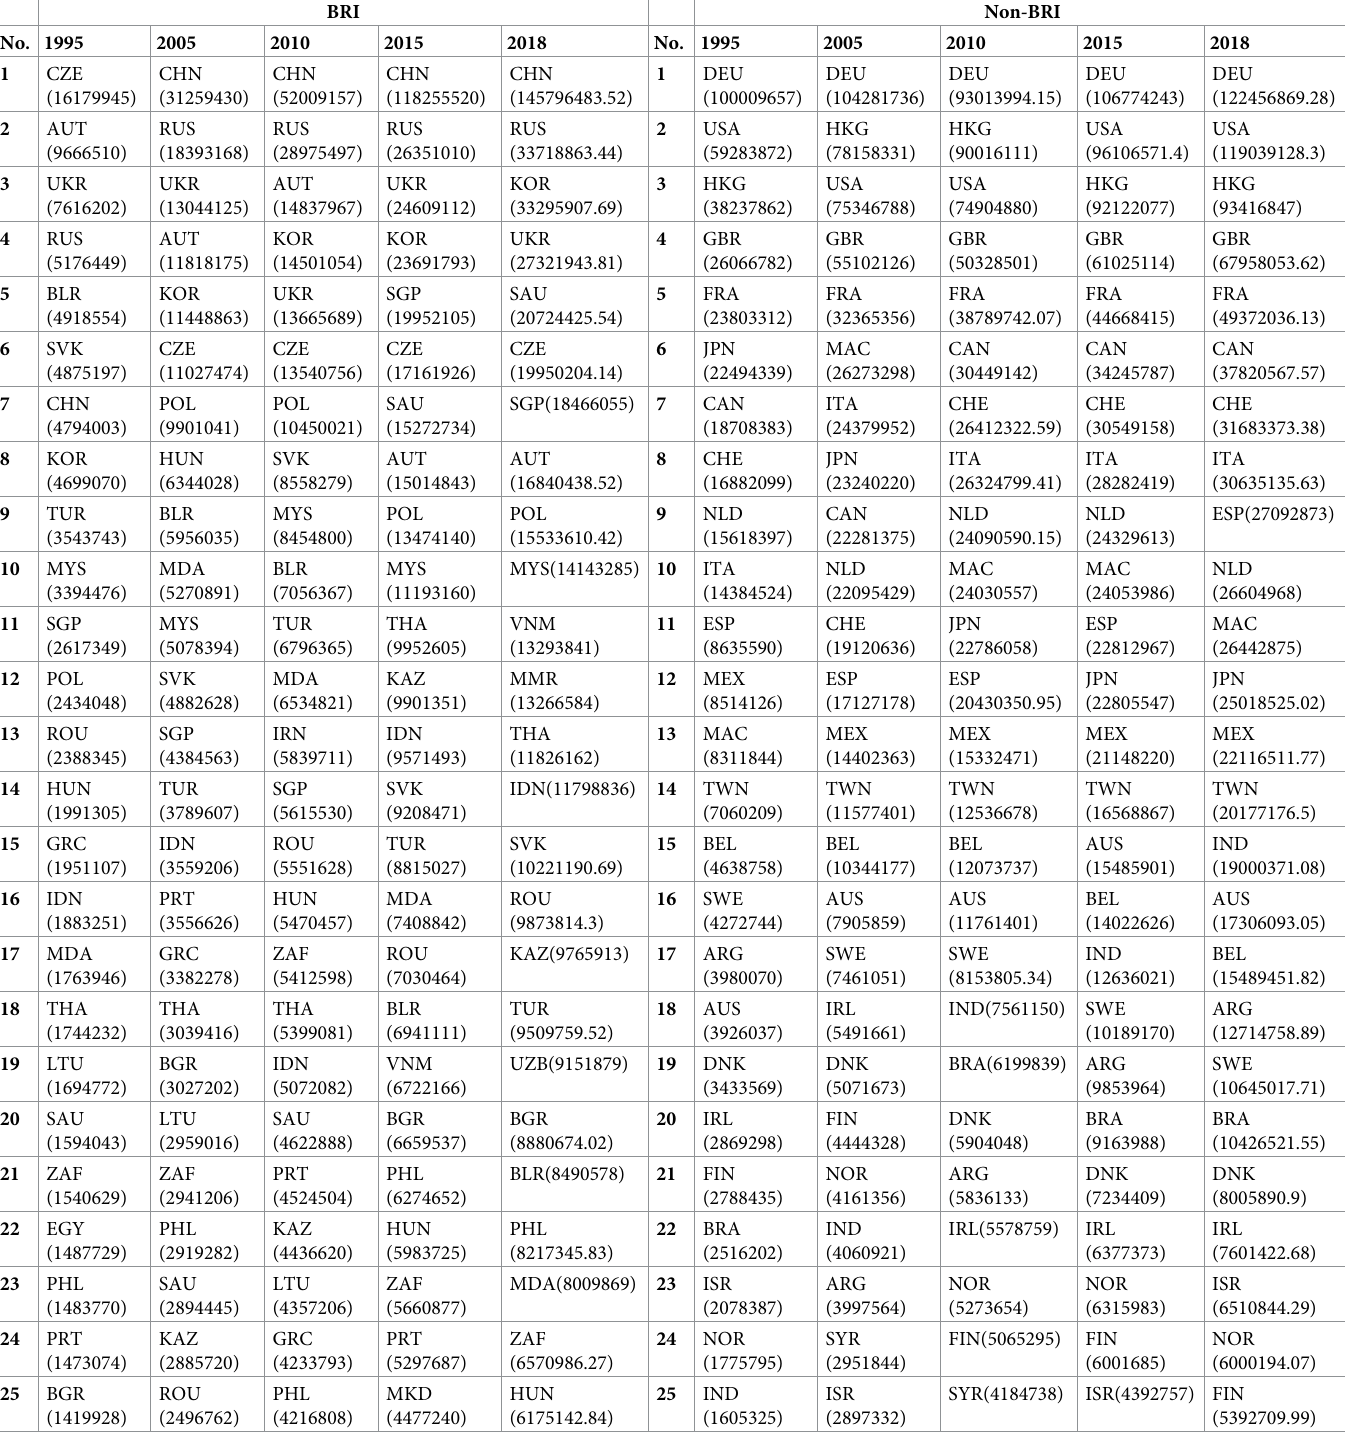
Table 3. Out-strength centralities of BRI and non-BRI